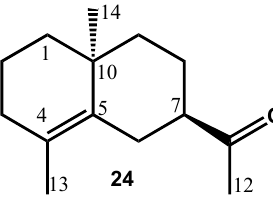
Figure 4. Structure of 10- epi -nor- γ -eudesmen-11-one ( 24 ). Table 2. NMR data of compound 24 .